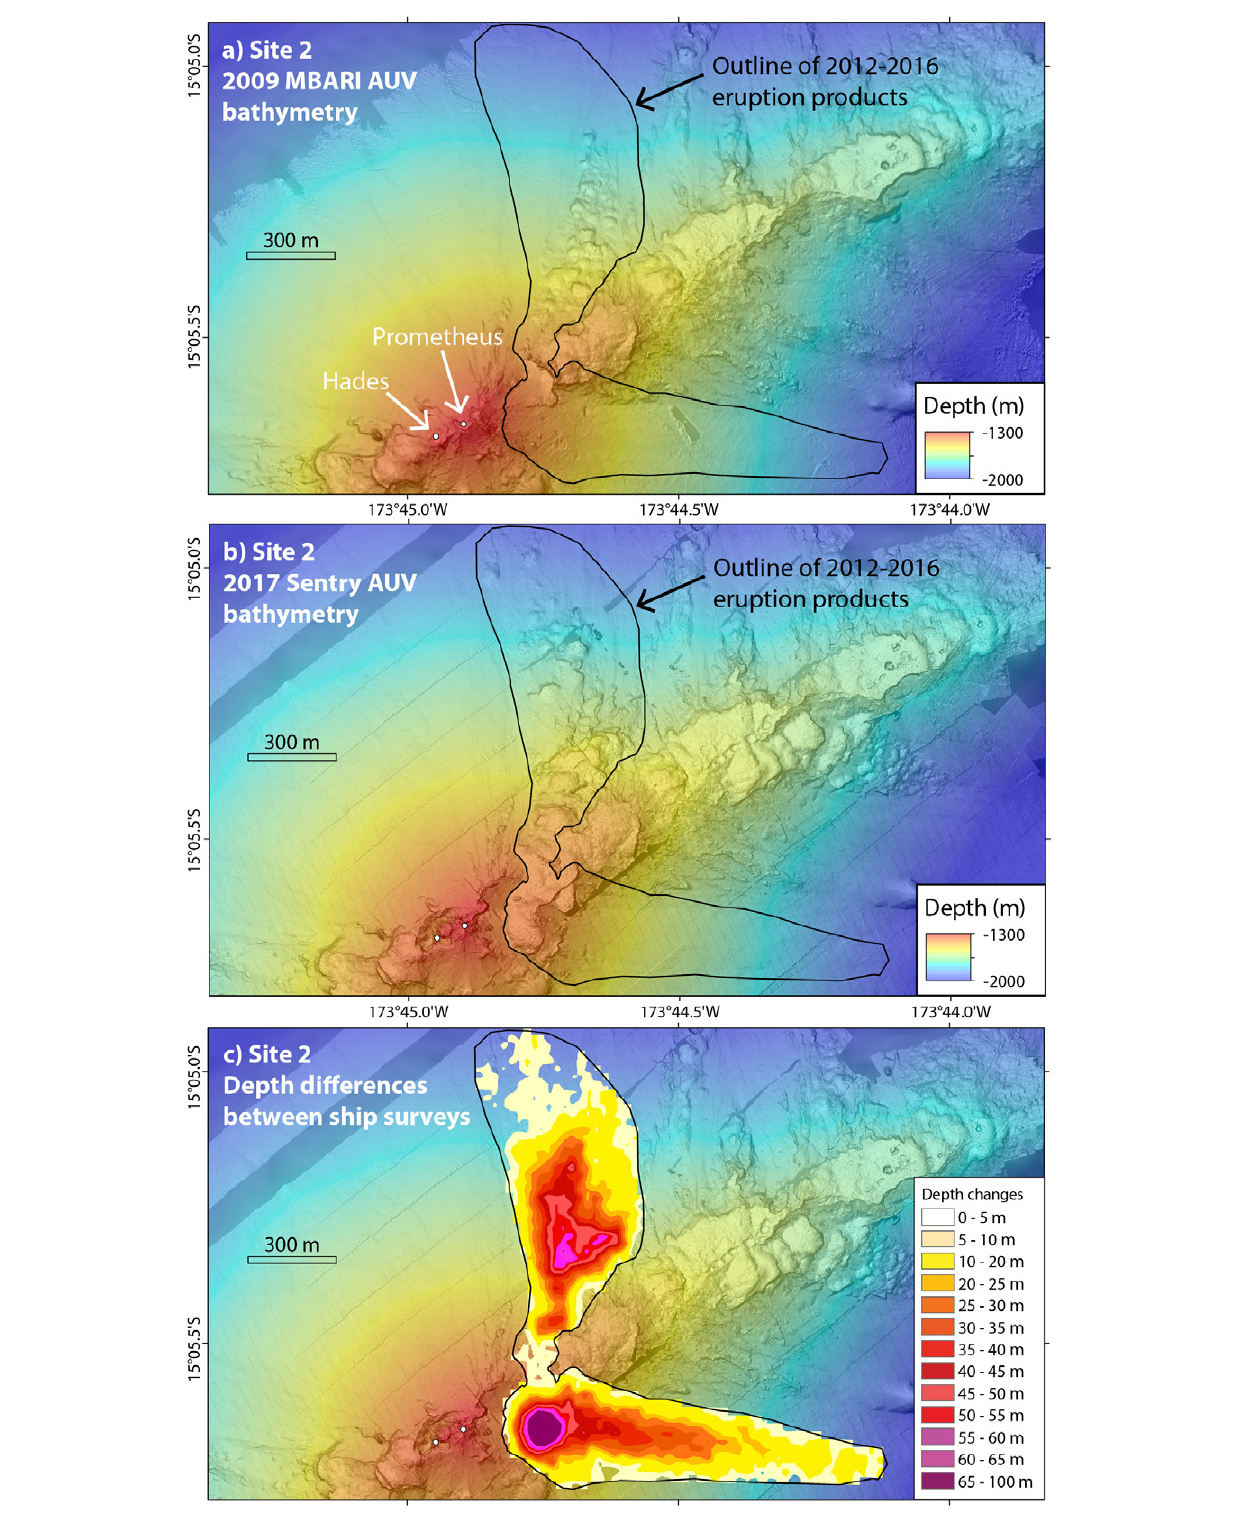
FIGURE 7 | Broad-view maps of eruption site #2, just east of the summit of West Mata (see Figure 2 ) showing (a) pre-eruption MBARI AUV bathymetry from 2009, (b) post-eruption Sentry AUV bathymetry from 2017, and (c) positive depth differences between ship-based surveys in 2012 and 2016 ( Table 2 ). Black outlines enclose the site #2 eruption deposits. White dots show locations of Hades and Prometheus eruptive vents in May 2009.